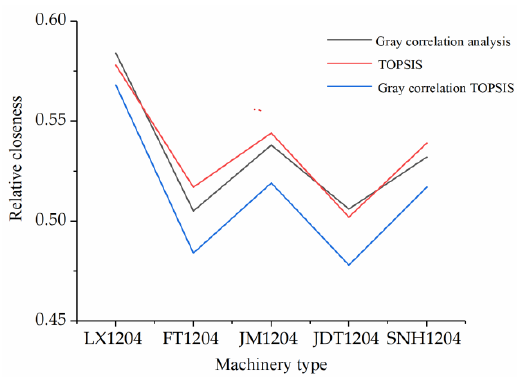
Figure 5. Comparison of relative closeness of three methods.